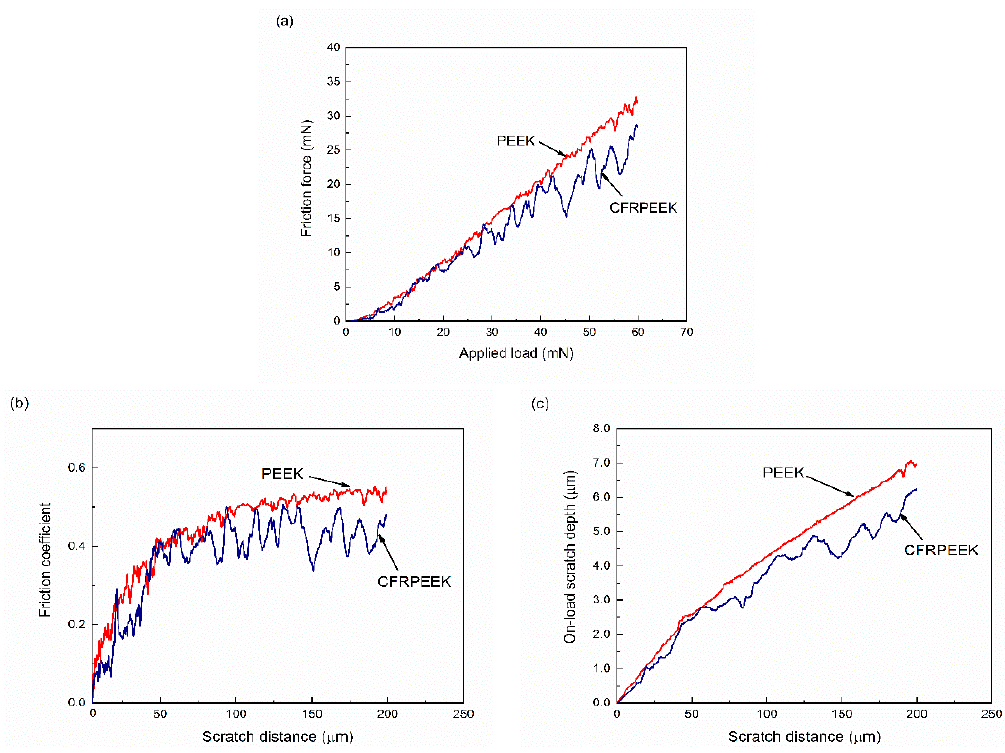
Figure 2. Variations of ( a ) friction force and ( b ) friction coefficient and ( c ) on-load scratch depth of PEEK and CFRPEEK in progressive load nanoscratch tests with an initial load of 0.3 mN and a final load of 60